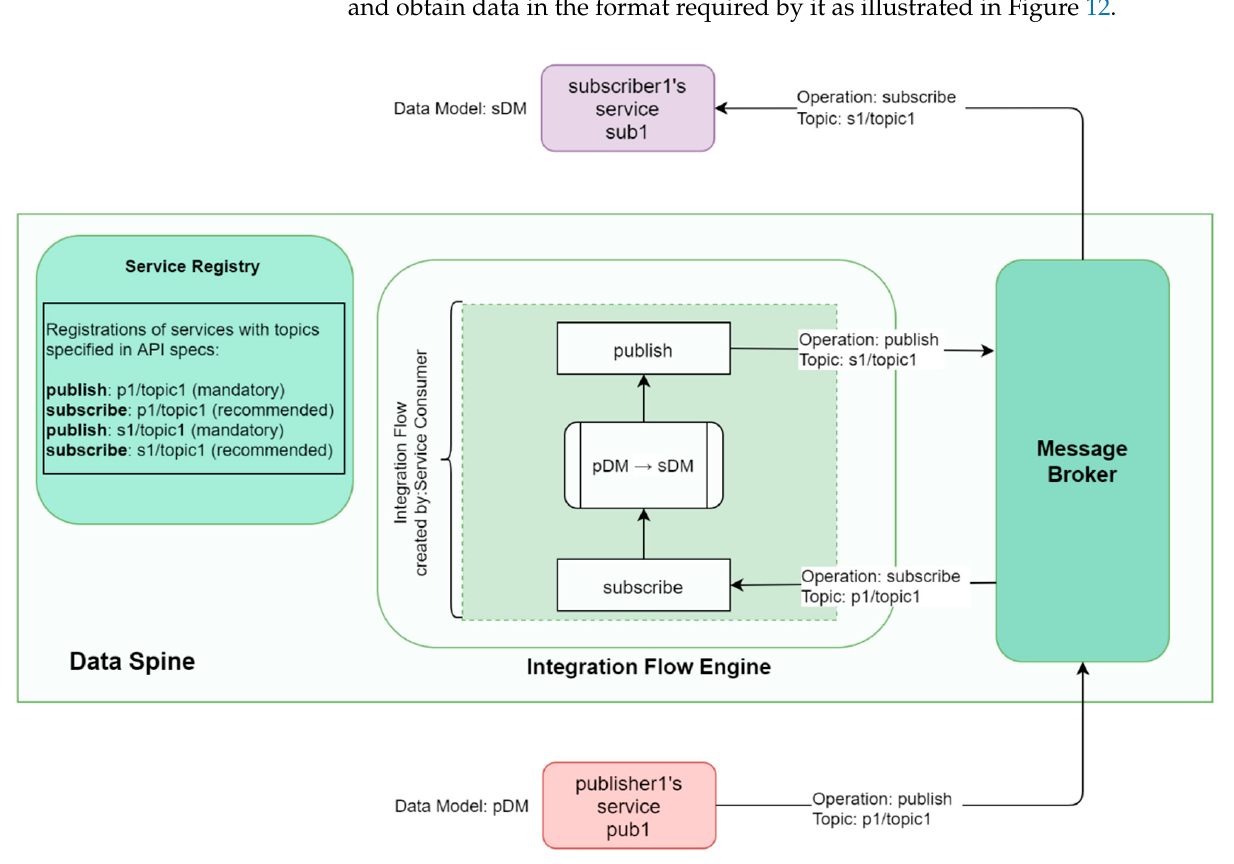
Figure 12. Example of asynchronous communication workflow through the Data Spine.